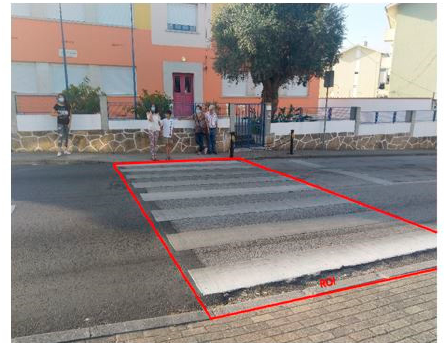
Figure 9. Test scenario with single region of interest (ROI) (crosswalk).